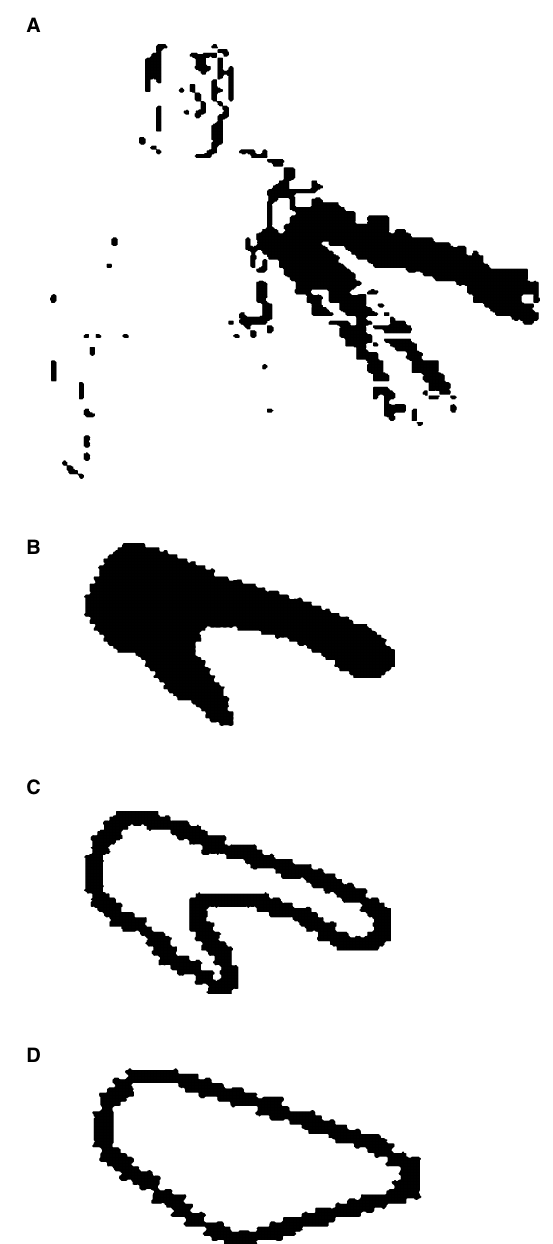
Fig. 6. Example image processing sequence used to extract an ideal contour from the human’s movements. (a) Original image obtained from the MHI process. (b) Image obtained from the Median Filter. (c) Image obtained from the Canny Edge Detection algorithm. (d) Image obtained from the convex Hull.